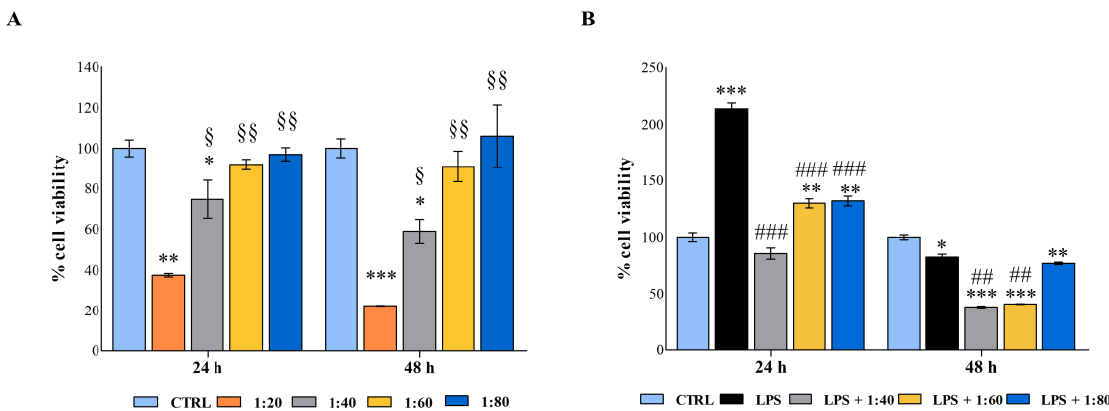
Figure 2. ( A ) 3-(4,5-dimethylthiazol-2-yl)-5-(3-carboxymethoxyphenyl)-2-(4-sulfophenyl)-2 H -te- trazolium (MTS) assay performed on human macrophages treated for 24 and 48 h with SS diluted at 1:20, 1:40, 1:60, and 1:80 within the culture medium. ( B ) MTS assay performed on lipopolysaccha- ride (LPS)-stimulated human macrophages treated for 24 and 48 h with SS diluted at 1:40, 1:60, and